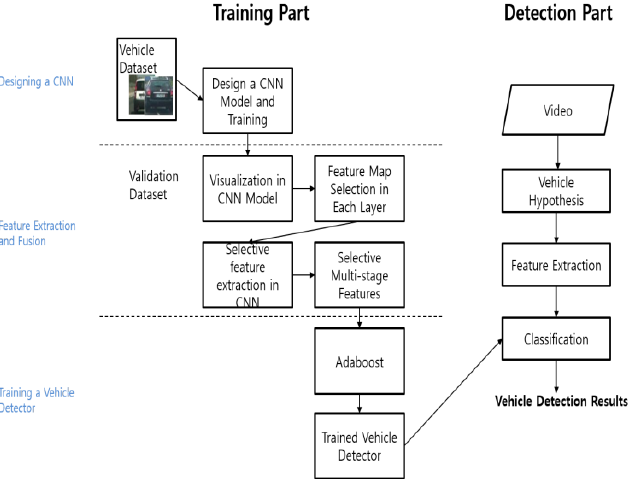
Figure 1. Proposed vehicle detection framework.